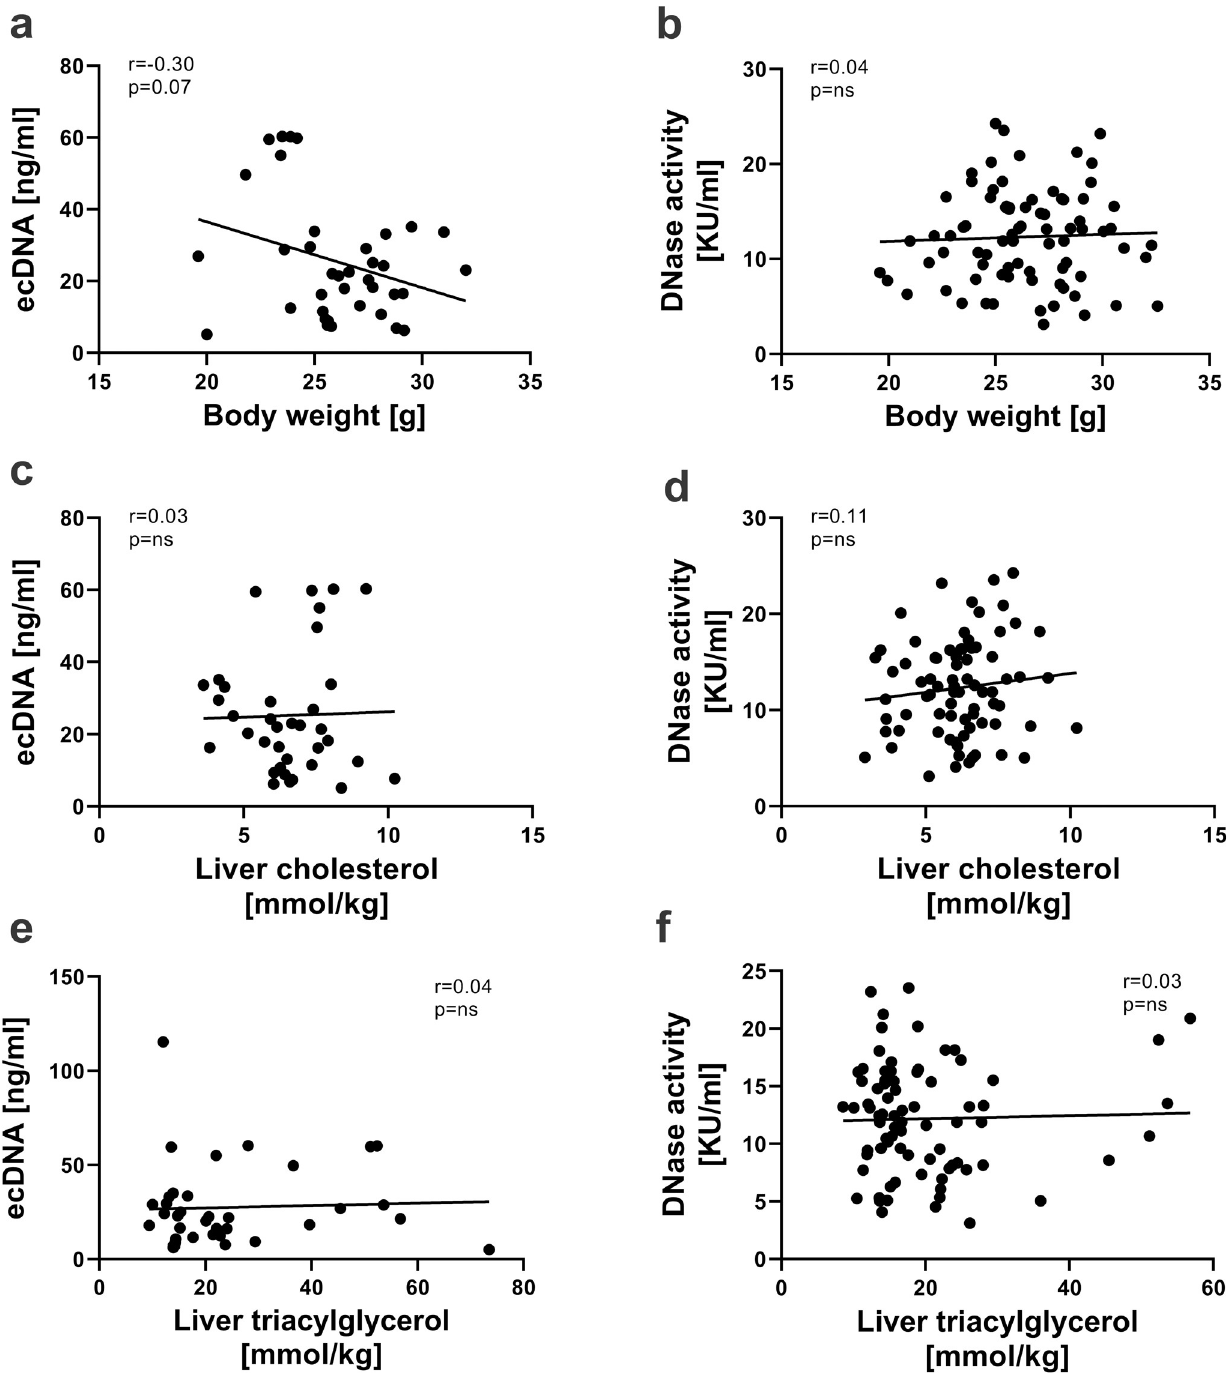
Fig 1. Relationship of ecDNA and DNase activity with body weight, cholesterol and triacylglycerol in the liver. Correlations between ecDNA and body weight (a), cholesterol (c) or triacylglycerol in the liver (e). Correlations between DNase activity and body weight (b), cholesterol (d) or triacylglycerol in the liver (f). ecDNA—extracellular DNA; KU—Kunitz units.